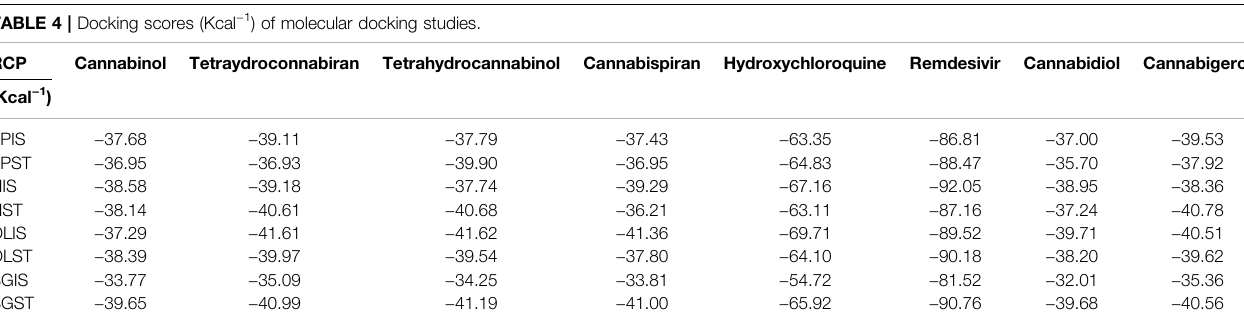
TABLE 4 | Docking scores (Kcal − 1 ) of molecular docking